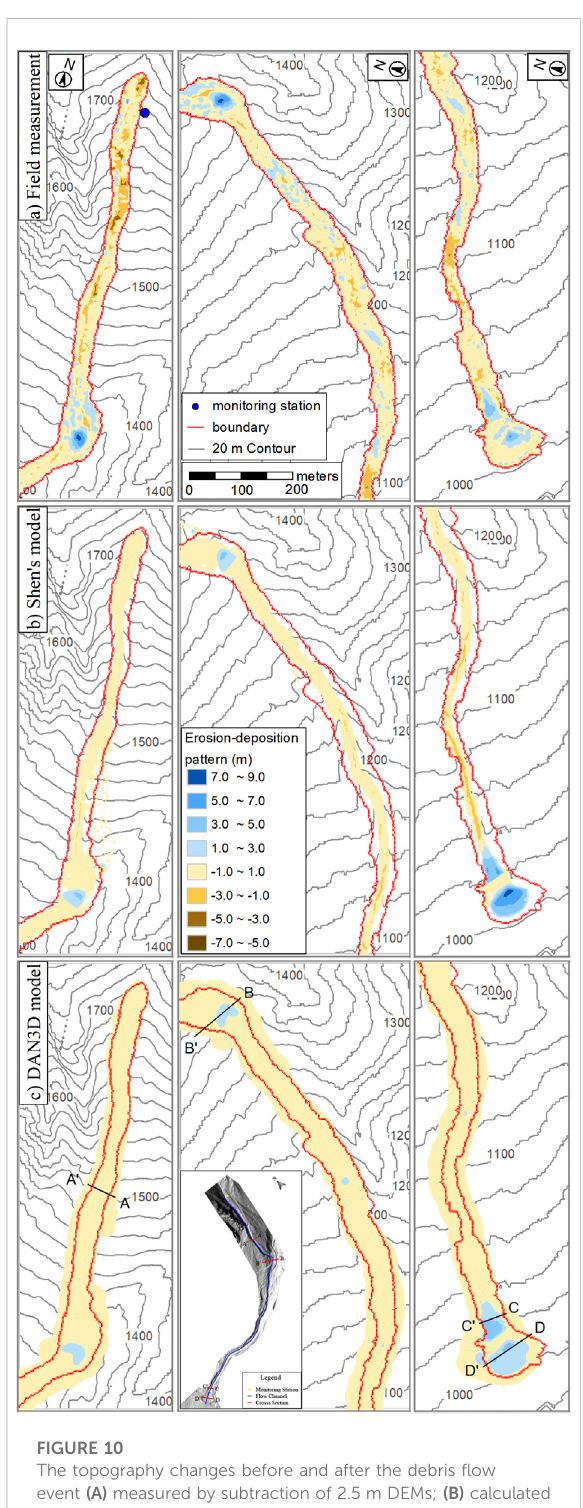
FIGURE 10 The topography changes before and after the debris fl ow event (A) measured by subtraction of 2.5 m DEMs; (B) calculated by Shen ’ s model; (C) calculated by DAN3D